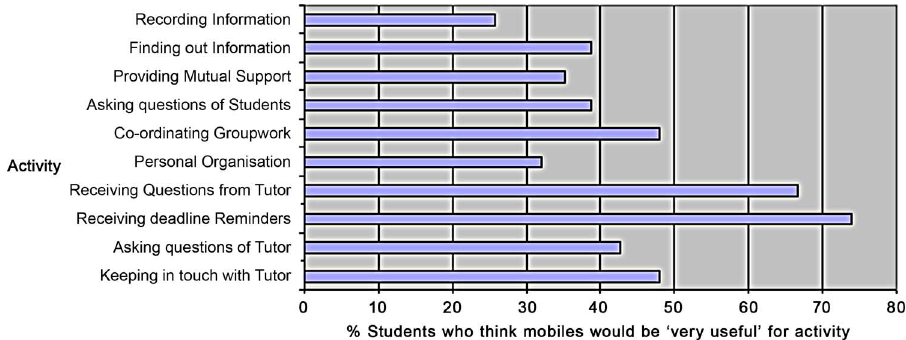
Figure 3. Student views about the potential for using mobile phones to support